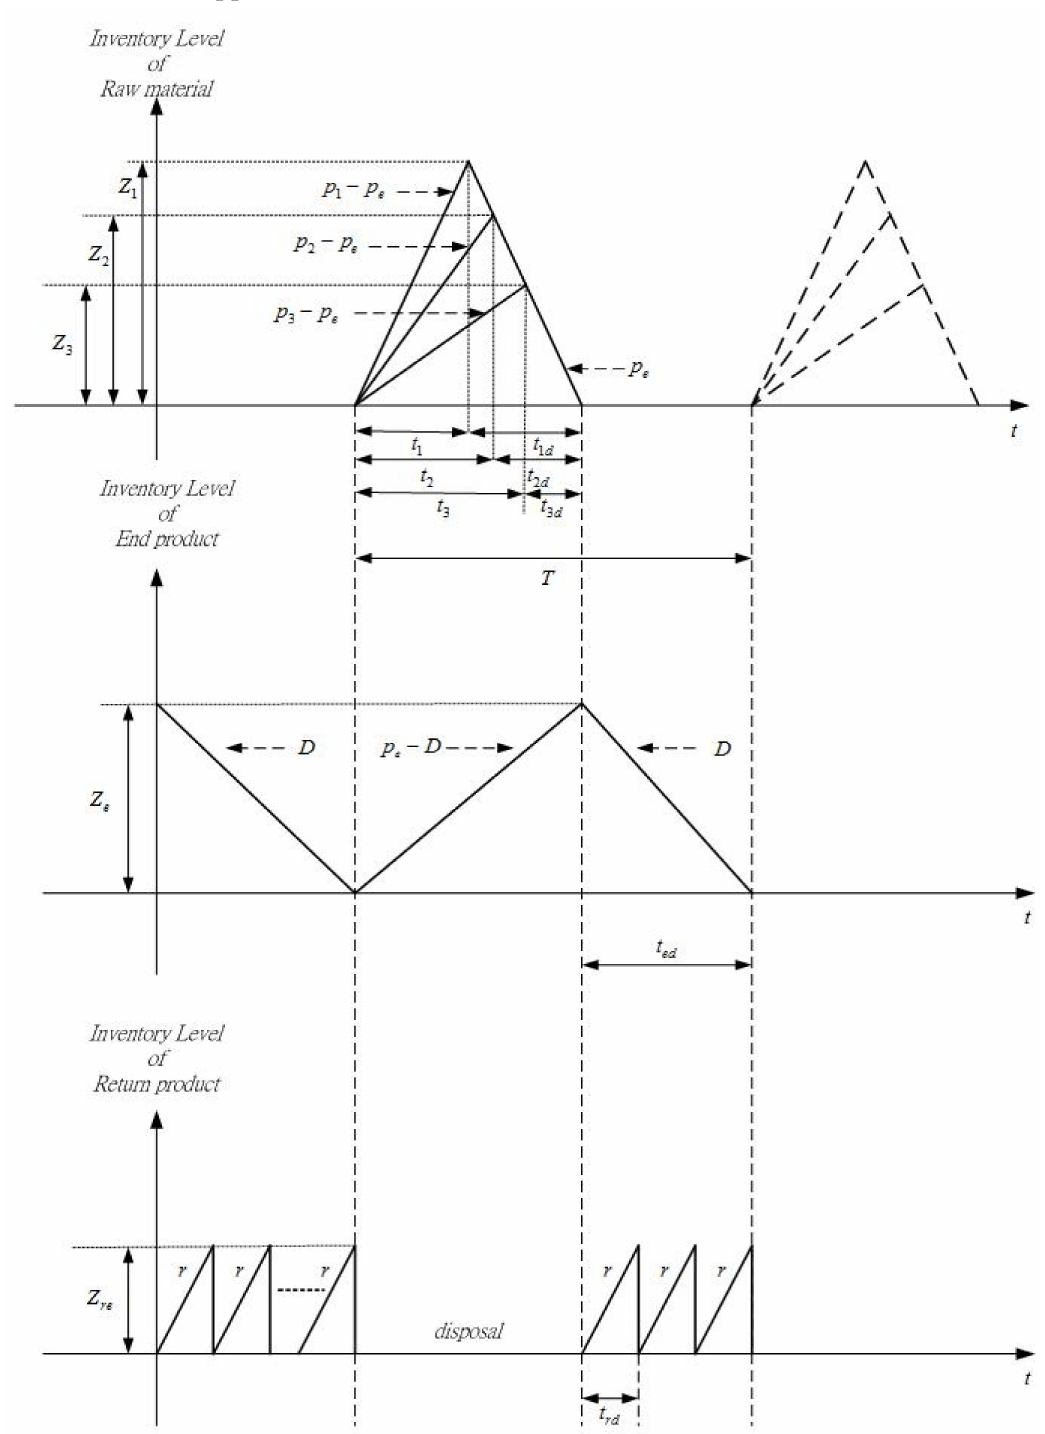
Figure A1. The graph of production system during time period [ 0 , T